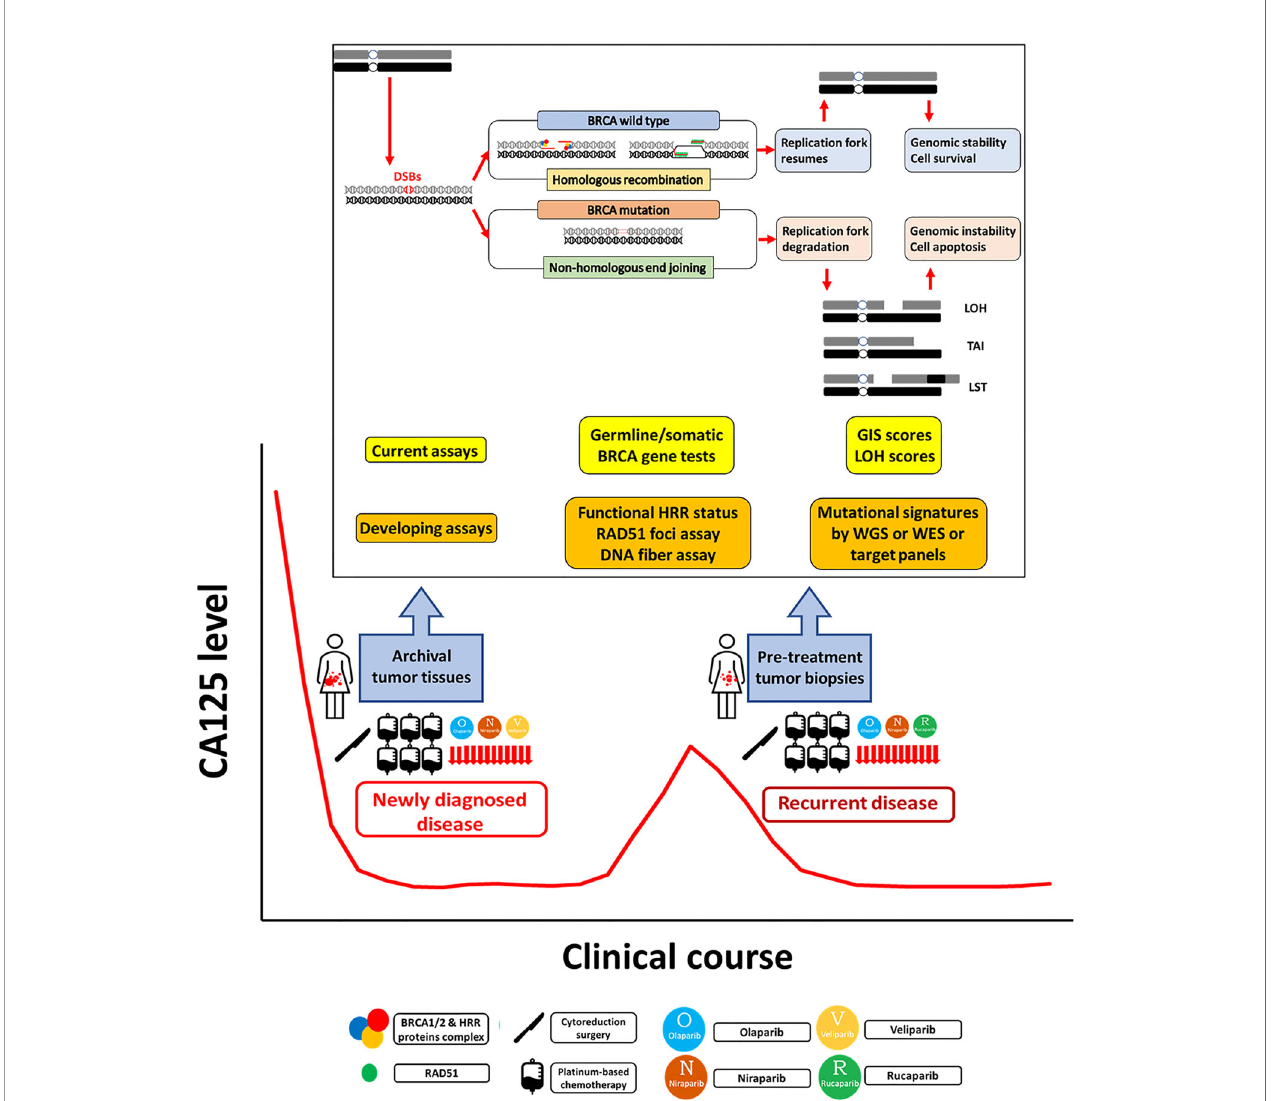
FIGURE 1 | Homologous recombination de fi ciency assays in epithelial ovarian cancer. Homologous recombination repair (HRR) is an important pathway for repairing DNA double-strand breaks (DSBs). In HRR, DSBs are detected and bound by BRCA1/2 and other HRR protein complexes to localize RAD51 to the exposed single- strand DNA, which then invades the DNA sequence on a homologous sister chromatid to synthesize the new DNA strand. Homologous recombination de fi ciency (HRD) occurs when HRR is impaired, especially by BRCA mutation. DSBs are repaired by other error-prone repair pathways, including nonhomologous end joining (NHEJ), which may cause point mutations, small insertions or deletions, and even large-scale chromosomal rearrangements in the repaired DNA strands. In the S phase of the cell cycle, the replication forks stop when encountering DNA damage to allow DNA repair before replication continues. After the damage is repaired, the stalled fork resumes replication. If the damage cannot be repaired, the stalled replication fork undergoes fork collapse, comprising fork degradation to cell apoptosis. In general, HRD assays have three main categories: germline or somatic mutations of genes in the HRR pathway, genomic scars or mutational signatures representing the patterns of genomic instability, and checking the functional status of HRR. Germline and somatic BRCA tests should be performed in all patients with newly diagnosed epithelial ovarian cancer (EOC). The current HRD assays based on SNP-based microarray technologies measure loss of heterozygosity (LOH), telomeric allelic imbalance (TAI), and large-scale state transitions (LSTs). The genomic instability score (GIS) combines the information derived from the LOH, TAI, and LST to represent the degree of genomic instability. Functional assays of HRR status include RAD51 foci assays and DNA fi ber assays. The RAD51 subnuclear foci is generally present after DNA damage in normal cells, but HRD cells cannot form RAD51 foci. The DNA fi ber assay was developed to evaluate the dynamics of the replication fork. Mutational signatures describe distinct patterns of nucleotide transitions with the surrounding nucleotide context from next-generation sequencing (NGS) data for human tumors. The developing comprehensive genomic scar assays include whole genome sequencing (WGS), whole exome sequencing (WES), and target gene panels consisting of variable sizes of selected cancer-susceptible genes. PARPi maintenance therapy bene fi ts newly diagnosed advanced stage and platinum-sensitive recurrent EOC patients. The current genomic scar-based HRD assays can identify additional wild-type BRCA patients who may bene fi t from PARPi therapy. However, some issues need to be resolved. For tissue retrieval, multistep sampling to obtain archival and pretreatment tumor tissues over the clinical course has the potential to guide the therapy. For precision medicine, it is ideal to develop a comprehensive model to integrate clinical platinum sensitivity, genomic scar/mutational signatures, and functional tests to provide both past evidence of HRD and the current functional ability of